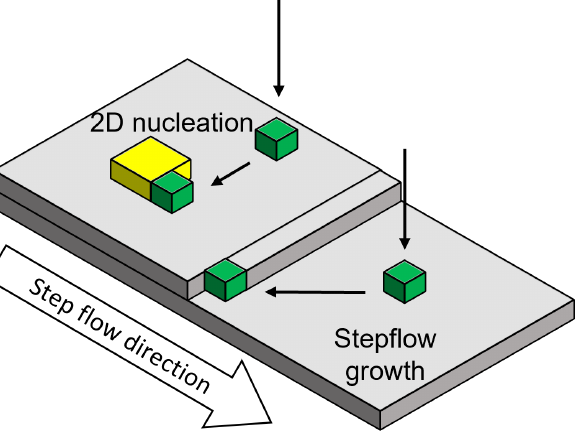
Figure 10. Scheme of two different growth schemes for the epitaxial growth. On the lower terrace, migration of the adatom at the edge of a growth step occurs, reproducing the substrate polytype. On the upper terrace, 2D nucleation takes place, which can lead to a switch in